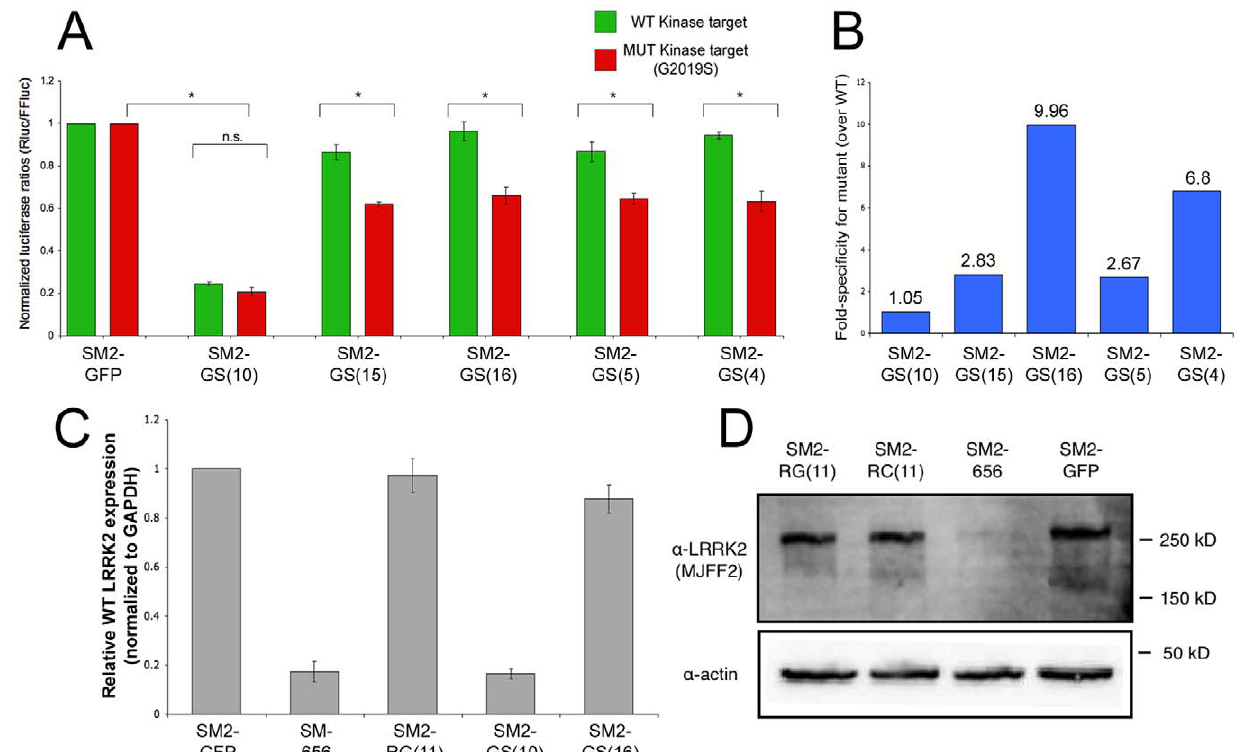
Figure 4. ASP-RNAi against G2019S LRRK2 alleles is most effective when MRS is not centrally located. A. Luciferase-based assays demonstrated that shRNA SM2-GS(10) has potent silencing capability but cannot discriminate between mutant and wild-type G2019 alleles. Shifting of the MRS either 5 9 or 3 9 within the guide strand increased the specificity of resulting shRNAs, but reduced their overall silencing strength. * denotes a p-value of , 0.01. B. A representation of fold-specificity is shown, calculated by comparing silencing strength of shRNA towards mutant template versus wild-type template. Average values were used for comparison. SM2-GS(16) was the best shRNA tested in this study in the compromise between specificity and silencing strength, but only slightly better that SM2-GS(4). C. Quantitative real-time PCR analysis of selected shRNAs shows that the effect of SM2-RG(11) and SM2-GS(16) on endogenous wild-type LRRK2 in 293FT cells is weak (3% and 12%, respectively) and therefore these are promising shRNAs for developing ASP-RNAi for the associated mutant alleles. D) Endogenous LRRK2 protein is only weakly silencing by SM2- RG(11) and SM2-RC(11) shRNAs, compared to the SM2-GFP control. A positive control, SM2-656, which targets a distinct region of WT LRRK2, is effective at silencing. LRRK2 was detected by immunoprecipitation, and actin is detected in input fractions.